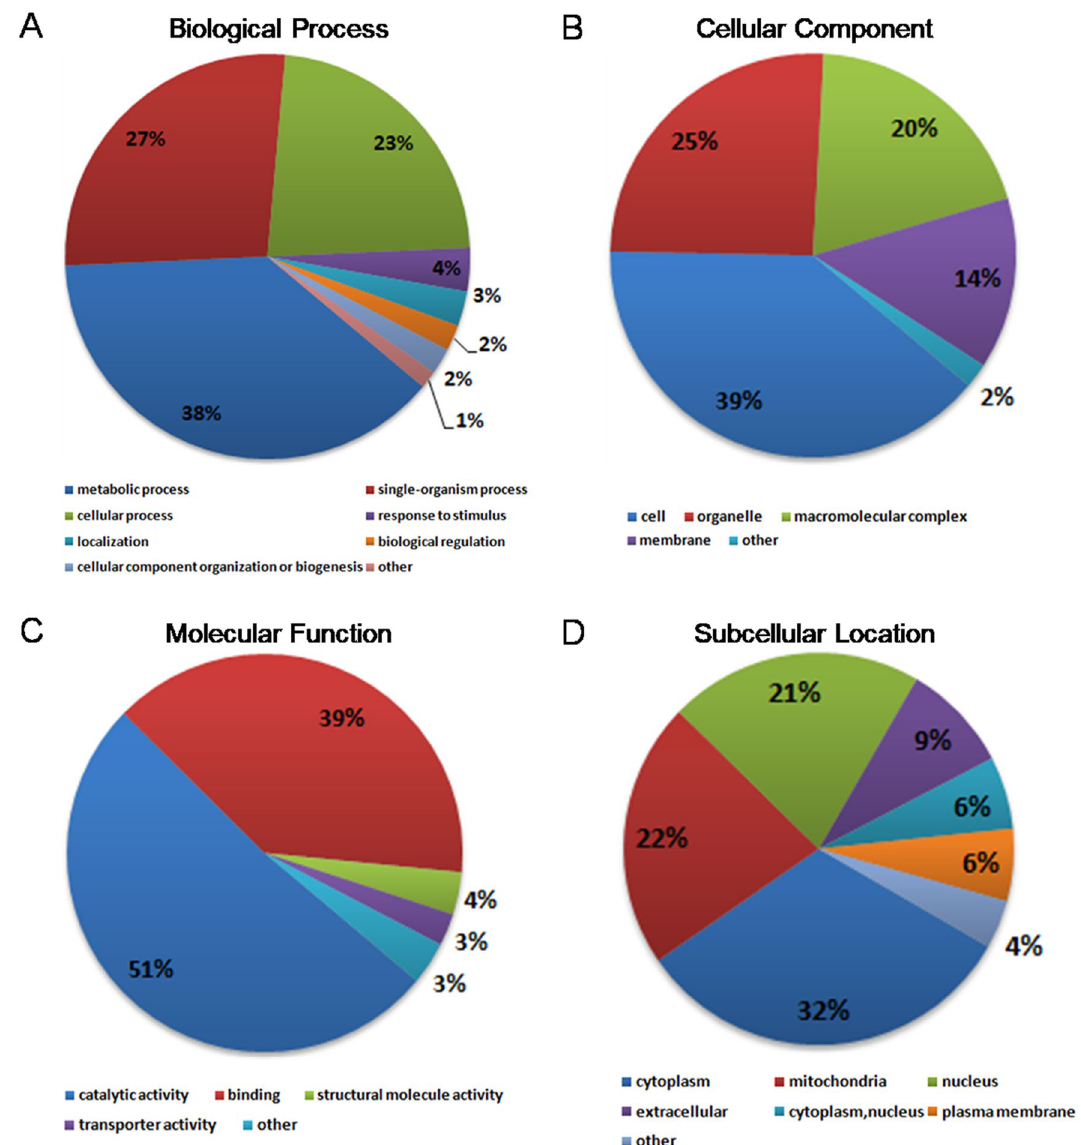
Figure 4. GO functional distribution and subcellular localization of differentially regulated Kac proteins in C. chloroleuca 67–1. ( A ) Biological process classification. ( B ) Cellular component classification. ( C ) Molecular function classification. ( D ) Subcellular